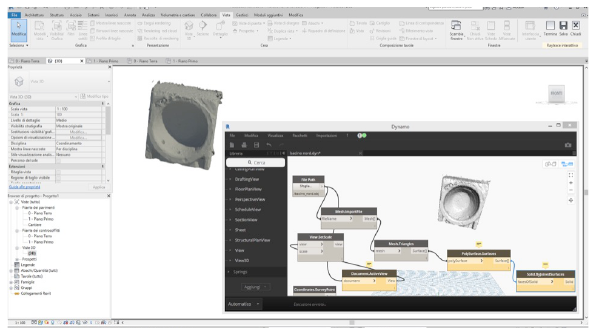
Figure 14: A screenshot into Revit showing the flow chart designed by